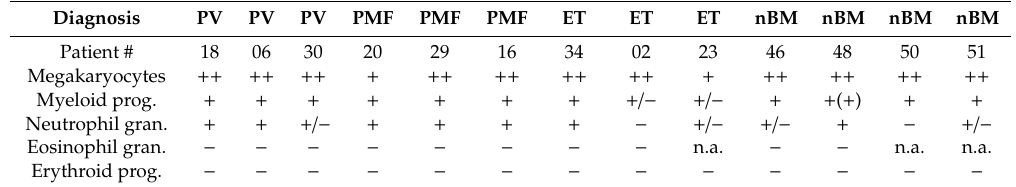
Table 1. Immunohistochemical detection of pSTAT5 in bone marrow cells of MPN patients and controls. Diagnosis